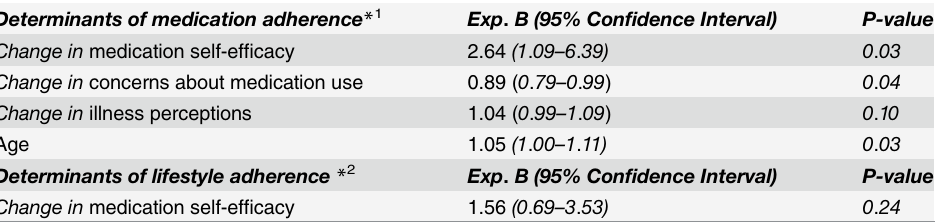
Table 3. Associations between changes in adherence to medication and lifestyle recommendations and changes in determinants of adherence at six months. Determinants of medication adherence *